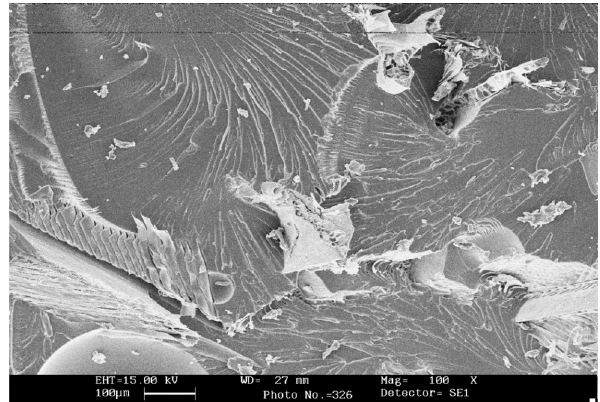
Figure 6: Scanning electron micrograph for 0.5% CR and 5.0% CFF composite.